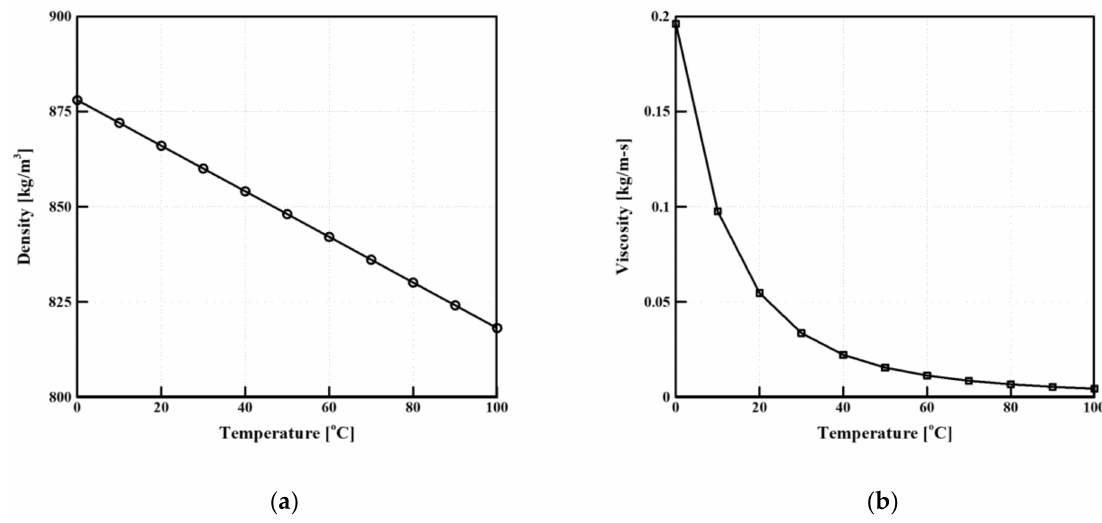
Figure 3. Cooling oil properties: ( a ) density; ( b )